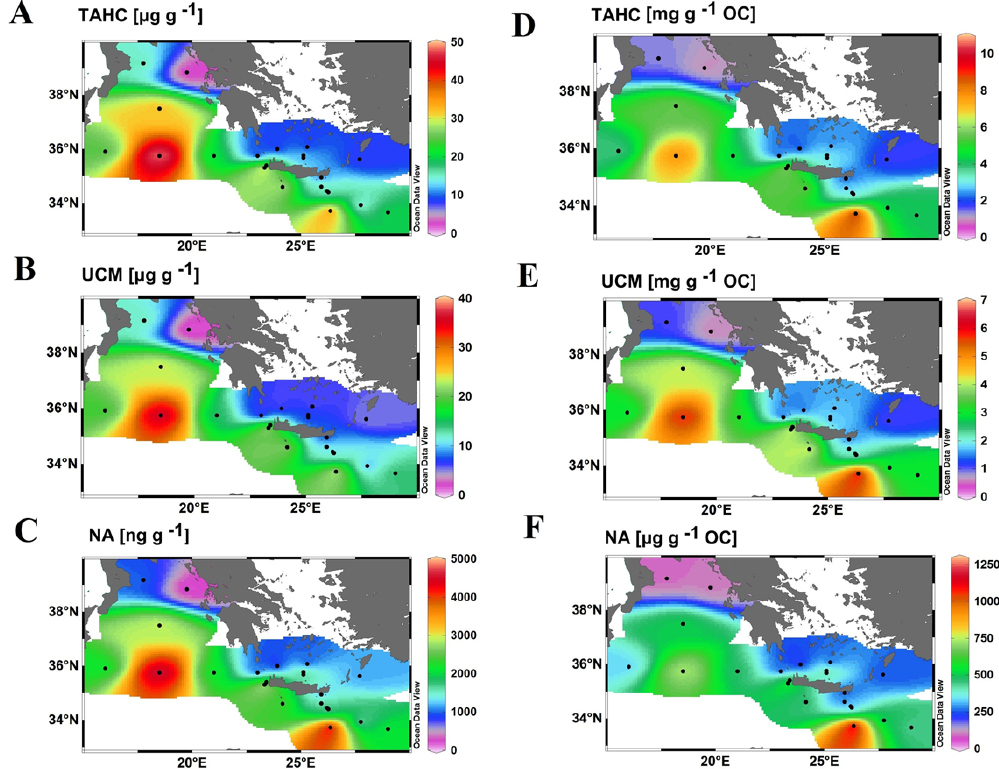
Fig. 3. Spatial contour maps of TAHC, UCM and NA absolute (per dry weight) and their OC-normalized concentrations in deep-sea sediments across the eastern Mediterranean Sea. TAHC, UCM and NA are defined in the